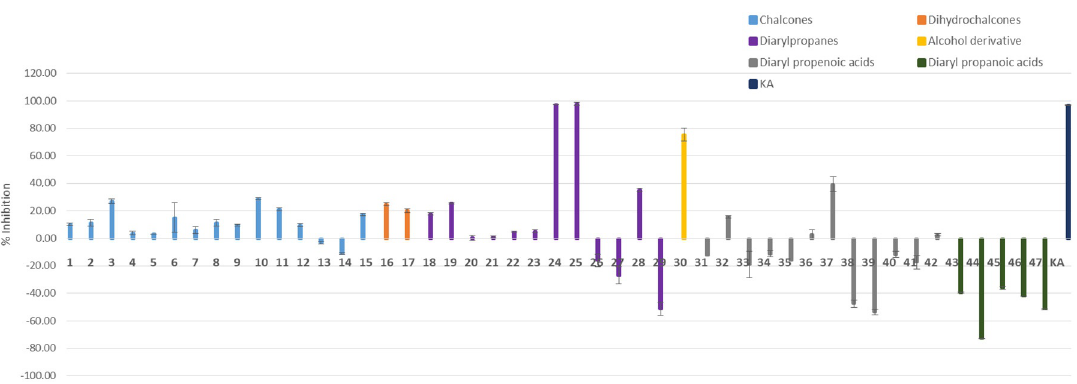
Figure 2. % Inhibitory activity against tyrosinase of 47 synthetic compounds (Bars, ± SD (n = 3)).